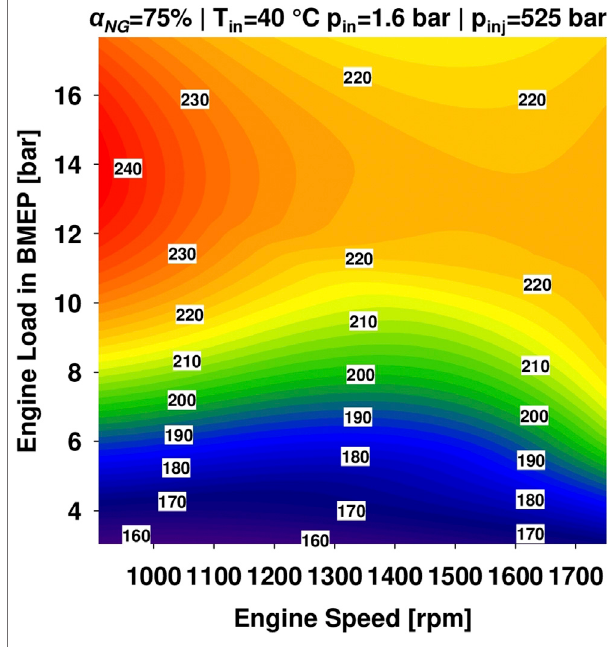
FIGURE 9 | Load-speed map of injection tip temperature at natural gas fraction of